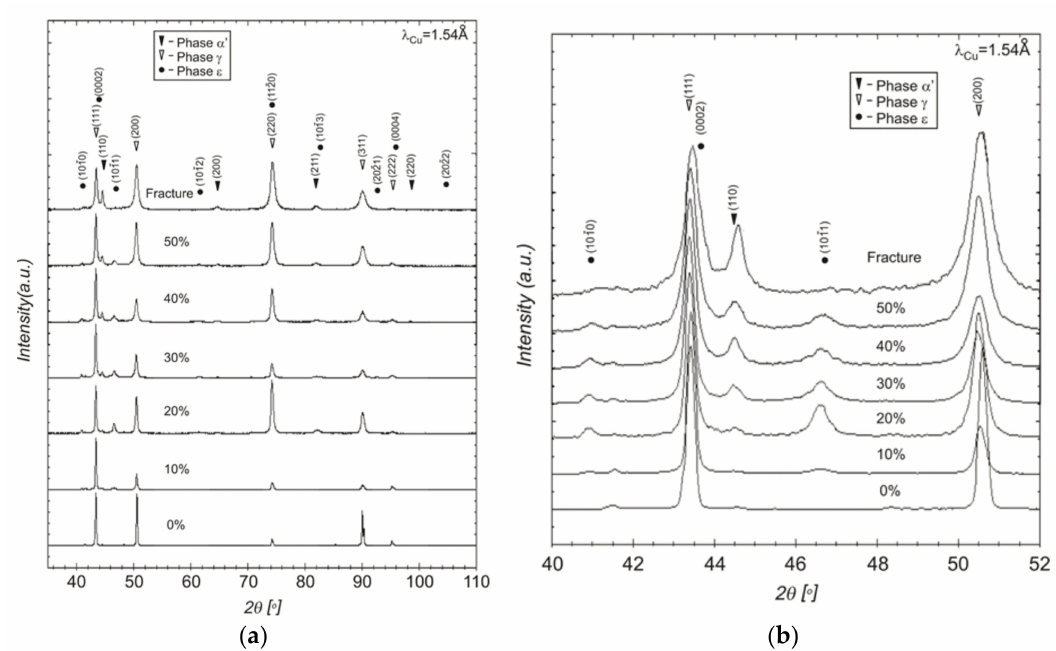
Figure 4. X-ray diffraction patterns of Fe-21.2Mn-2.73Si-2.99Al steel in the initial state (0%), after deformation 10–50% and after fracture ( a ), the expanded fragments of the plots, from the range between (111) γ and (200) γ of austenite diffraction peaks ( b ).